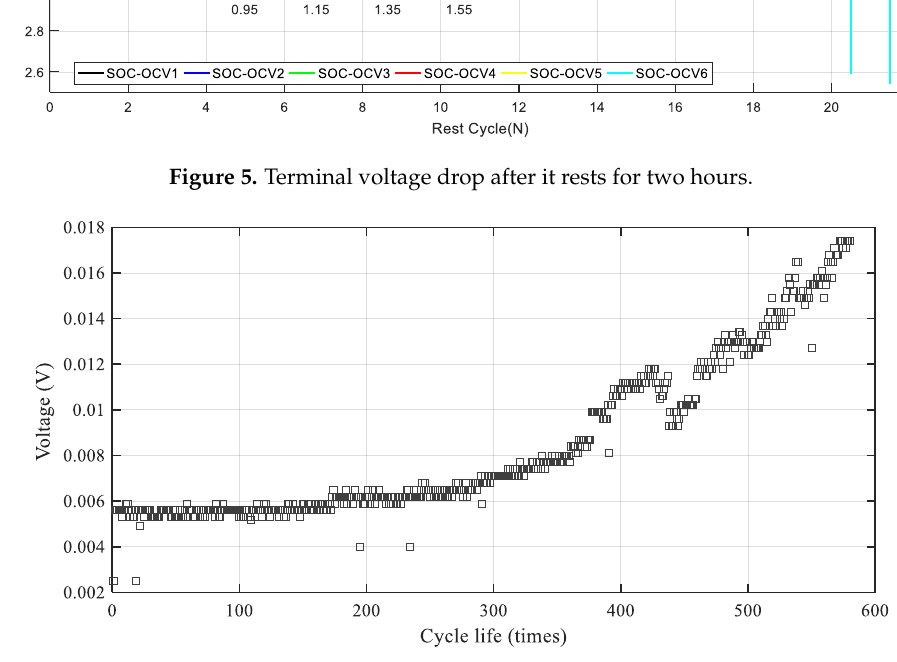
Figure 6. Cycle life vs. voltage drop.